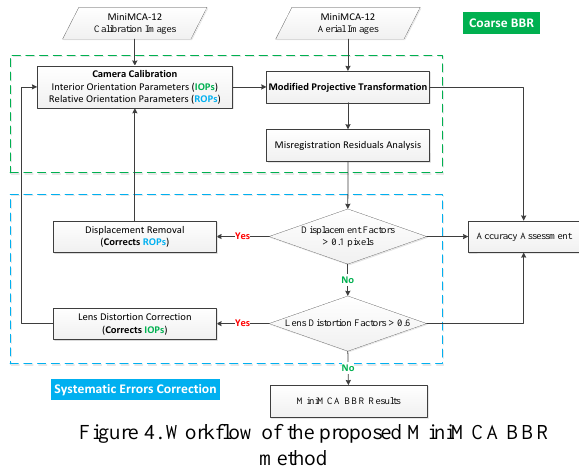
Figure 4. Workflow of the proposed MiniMCA